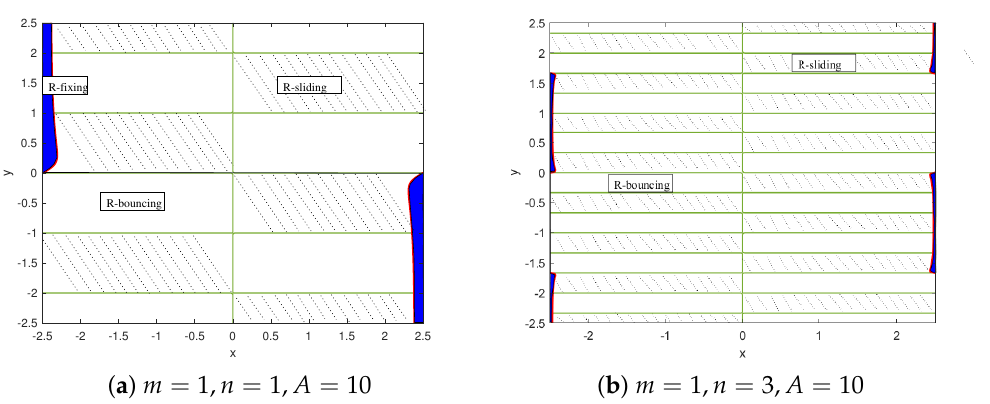
Figure 4. Particle motion modes distribution results with A =